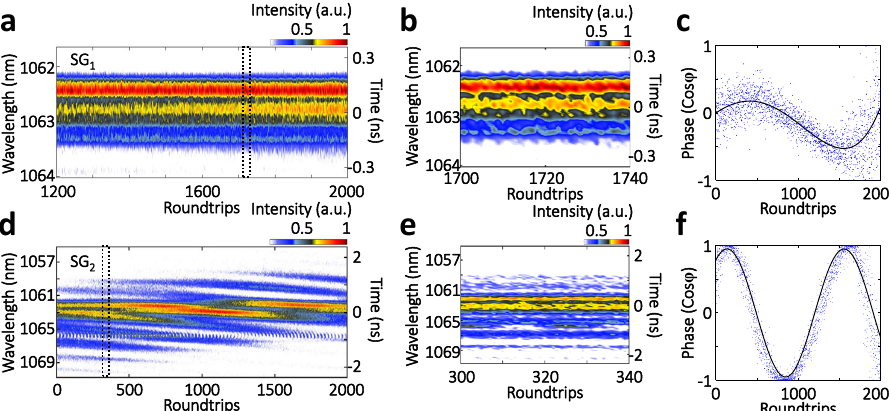
Fig. 4 Spectral dynamics of 3D soliton molecules. a , d Spectral evolutions in speckle grains SG 1 and SG 2 . b , e Close-ups as indicated in a and d , respectively. As can be observed, the soliton molecules in different speckle grains have different spectral widths and temporal separations, which can be identi fi ed by the density of the interference fringes. c , f Phase evolutions of the interference fringes of a and d , respectively. Please note that, different from the birth stage, here the time-stretch spectroscopy is valid for the whole evolution in the established stage, and thus the “ Wavelength ” axis is moved to the left for differentiating it from that of the birth stage, the same case for Figs. 5 and